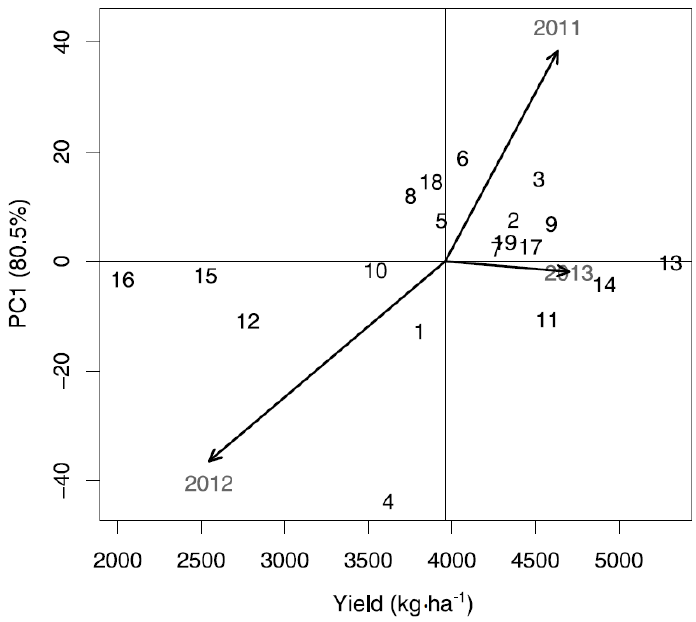
Figure 1. Additive Main effects and Multiplicative Interaction (AMMI) biplot for yield data showing yield (kg · ha − 1 ) versus the first principal component (PC1) score of the 19 winter wheat genotypes and the three years of production in the locality of Ekhaga. PC1 explains 80.5% of the genotype by year interaction variance. Genotypes are represented by the ID numbers from Table 1. Years of production are designated by the year of harvest. The vertical axis indicates the overall average yield (kg · ha − 1 ) across the three years of production. Genotypes closer to the horizontal axis (score 0 on PC1) had a relatively more stable yield across the three years.